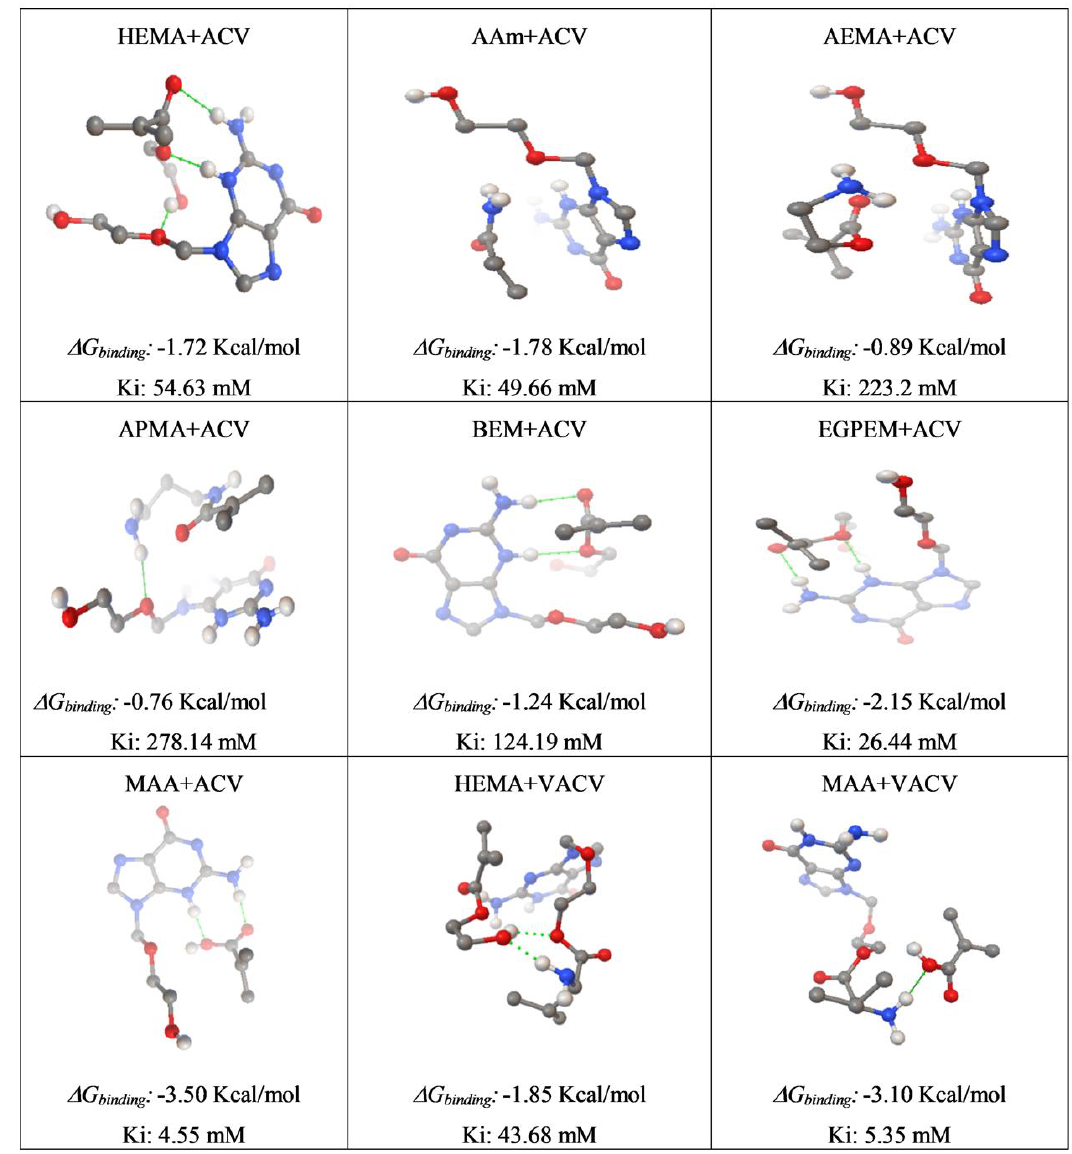
Figure 2. Computational modeling results of the interaction of acyclovir (ACV) with the monomers 2-hydroxyethyl methacrylate (HEMA), acrylamide (AAm), 2-aminoethyl methacrylate hydrochloride (AEMA), N-(3-aminopropyl) methacrylamide hydrochloride (APMA), butoxyethyl methacrylate (BEM), ethylene glycol phenyl ether methacrylate (EGPEM), and methacrylic acid (MAA); and the interaction of valacyclovir (VACV) with 2-hydroxyethyl methacrylate (HEMA) and methacrylic acid (MAA).